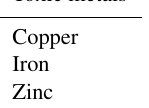
Toxic metals Copper Iron